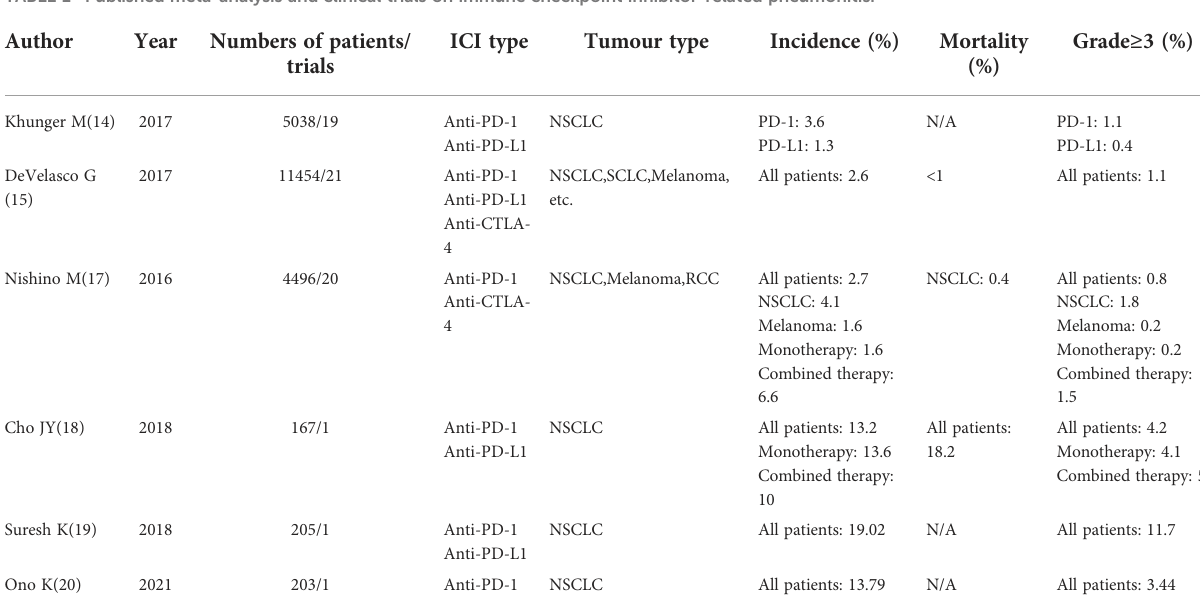
TABLE 1 Published meta-analysis and clinical trials on immune checkpoint inhibitor-related